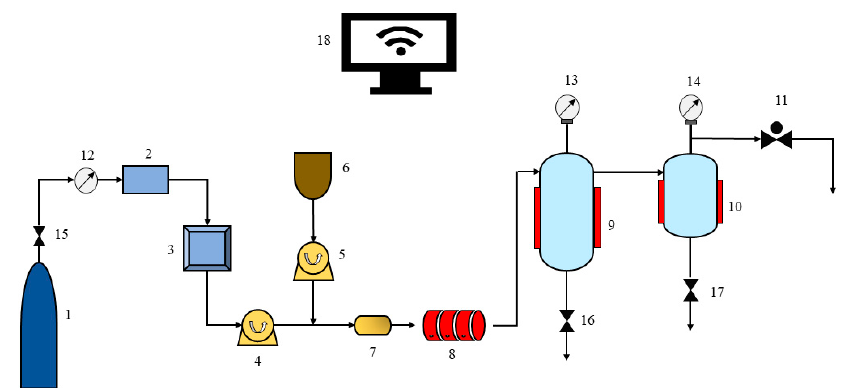
Figure 1. Diagram of the apparatus equipped with (1) CO 2 cylinder, (2) purifier, (3) refrigerator, (4) high-pressure pump (Model P-50A, Thar SFC, a Waters Co., USA), (5) co-solvent pump, (6) co-solvent tank, (7) mixer, (8) heat exchanger (Model 04424-1, Thar SFC, a Waters Co., USA), (9) dyeing autoclave (500 mL), (10) separation autoclave (200 mL), (11) back-pressure regulator, (12) flow gauge, (13–14) manometer, (15–17) valves.